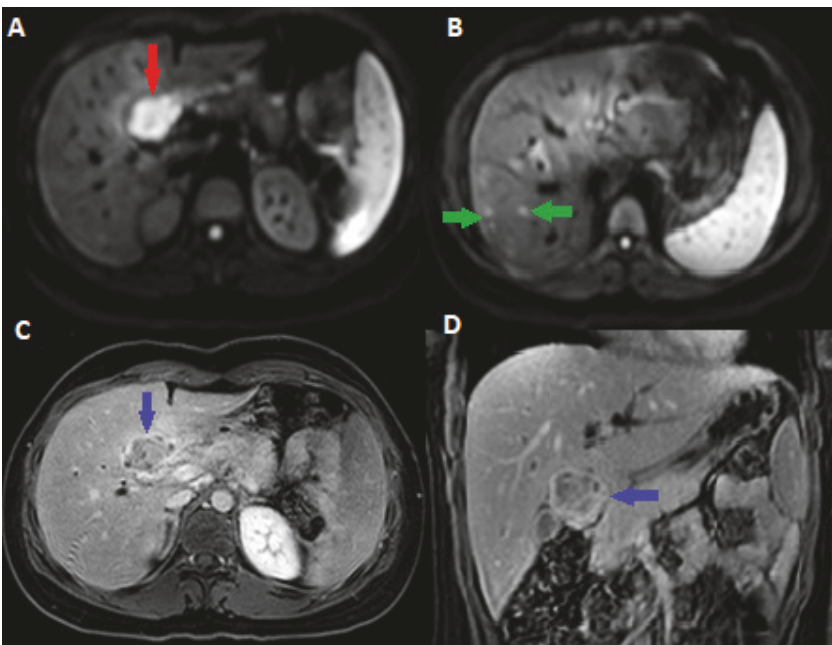
Figure 3: MRI of the liver axial diffusion-weighted (A, B) demonstrates a hyperintense mass in the region of the porta hepatis (red arrow) with a several hyperintense foci (green arrows). Axial postcontrast images (C, D) show heterogonous enhancement of porta hepatis mass (blue